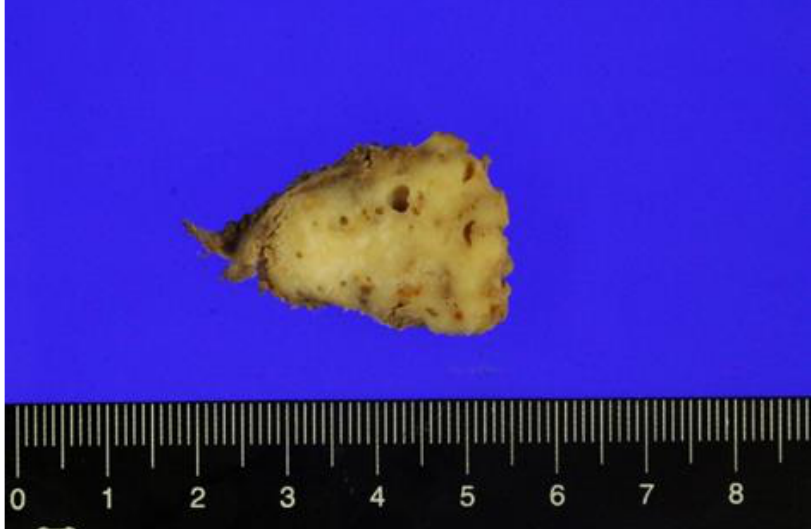
Figure 3. Cut surface of the resected specimen.